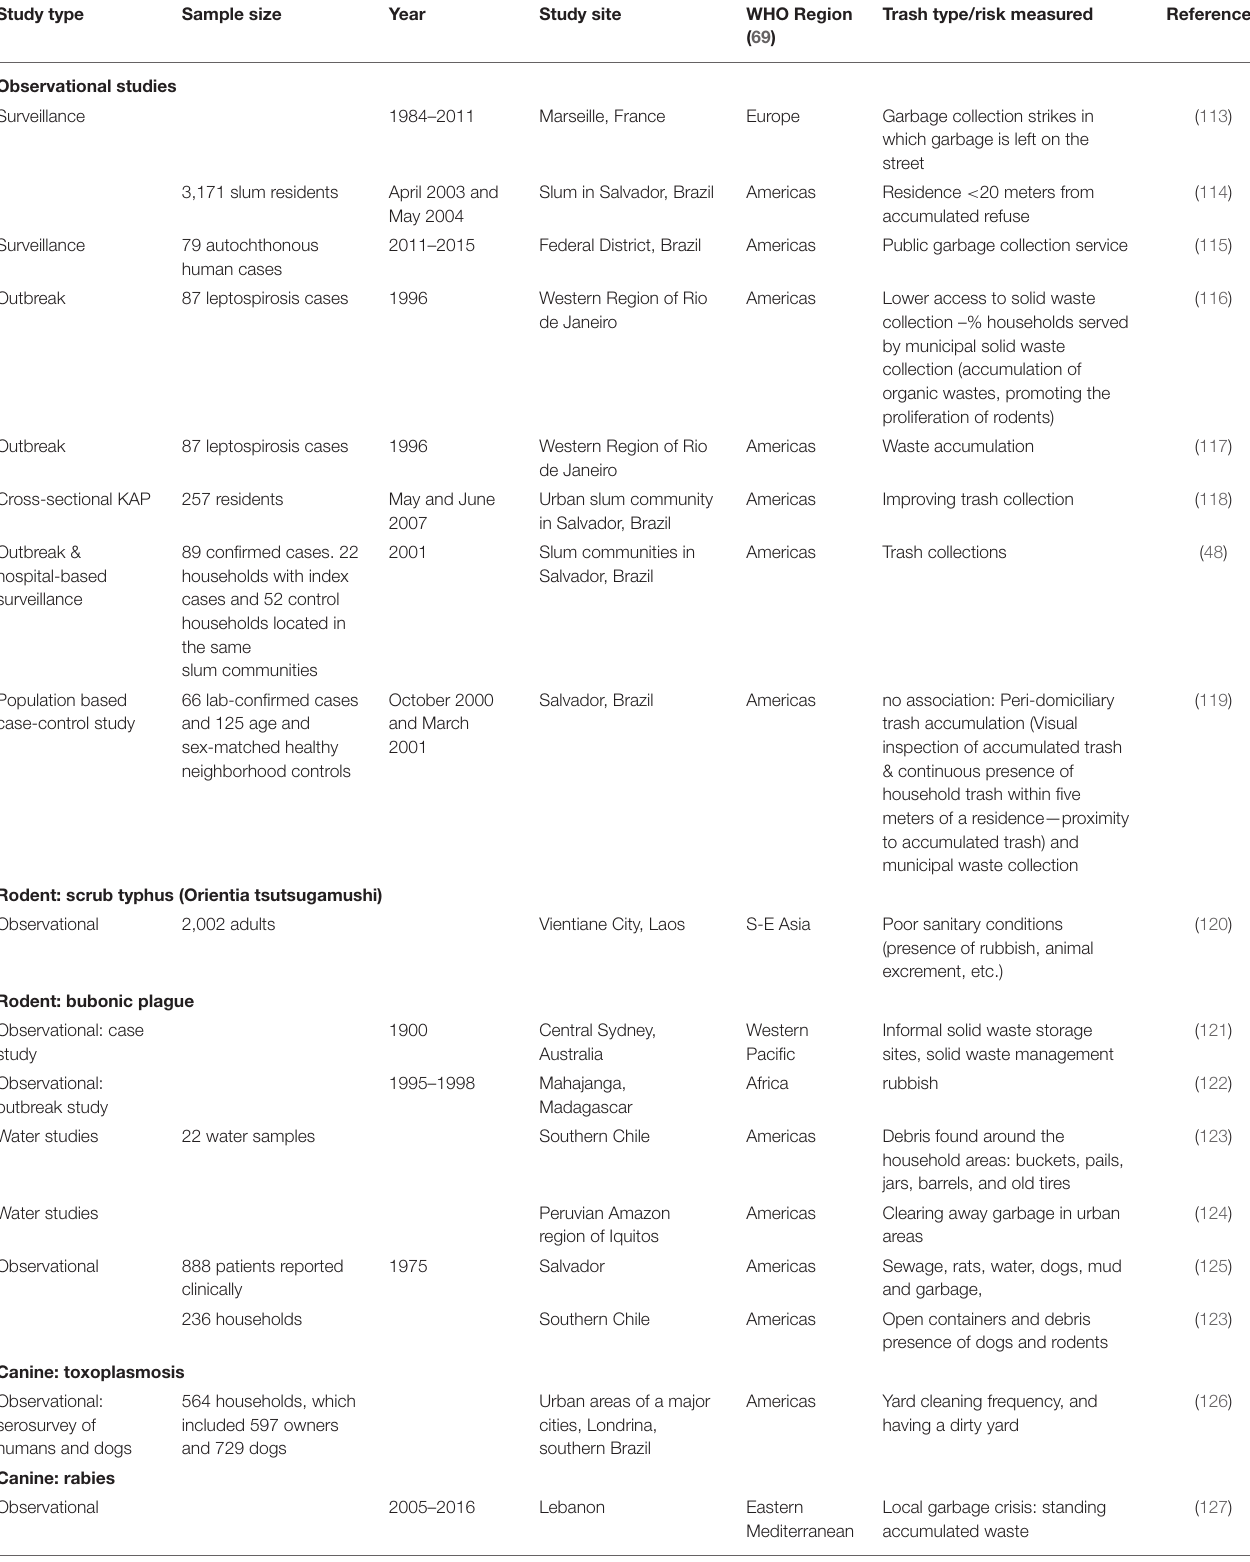
TABLE 2 | Urban zoonosis